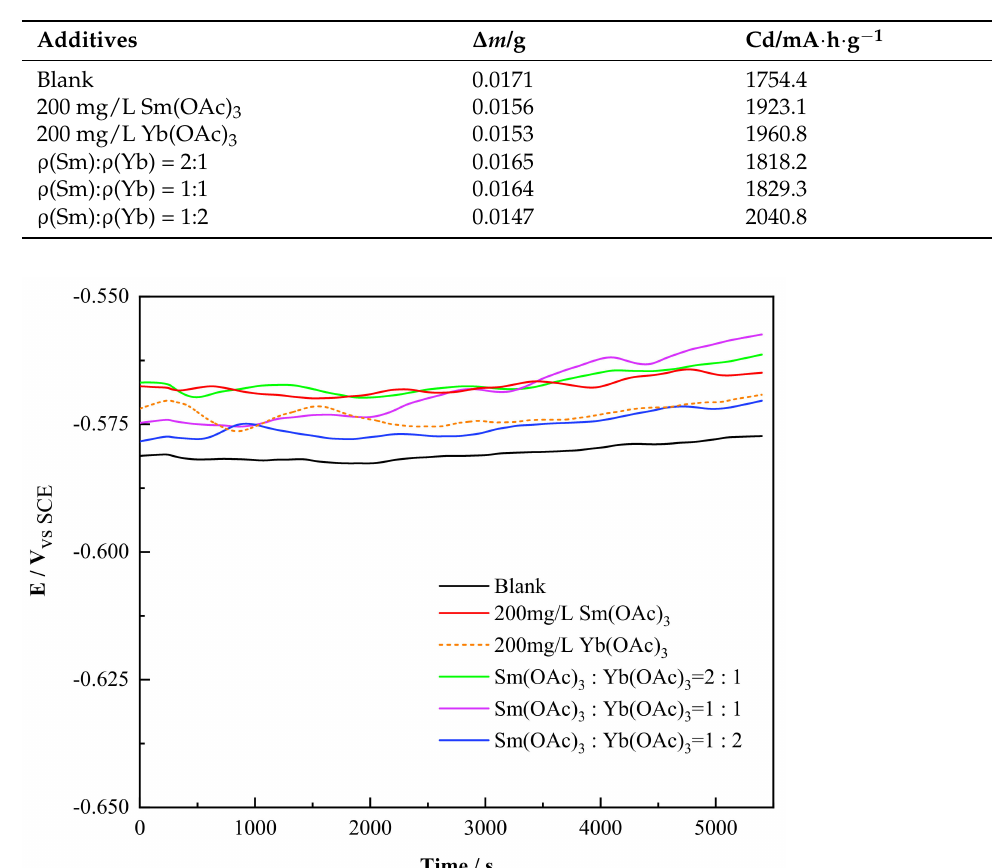
Table 3. The constant current (20 mA · cm − 2 ) discharge test data and battery capacity density calcula- tion with different additives.